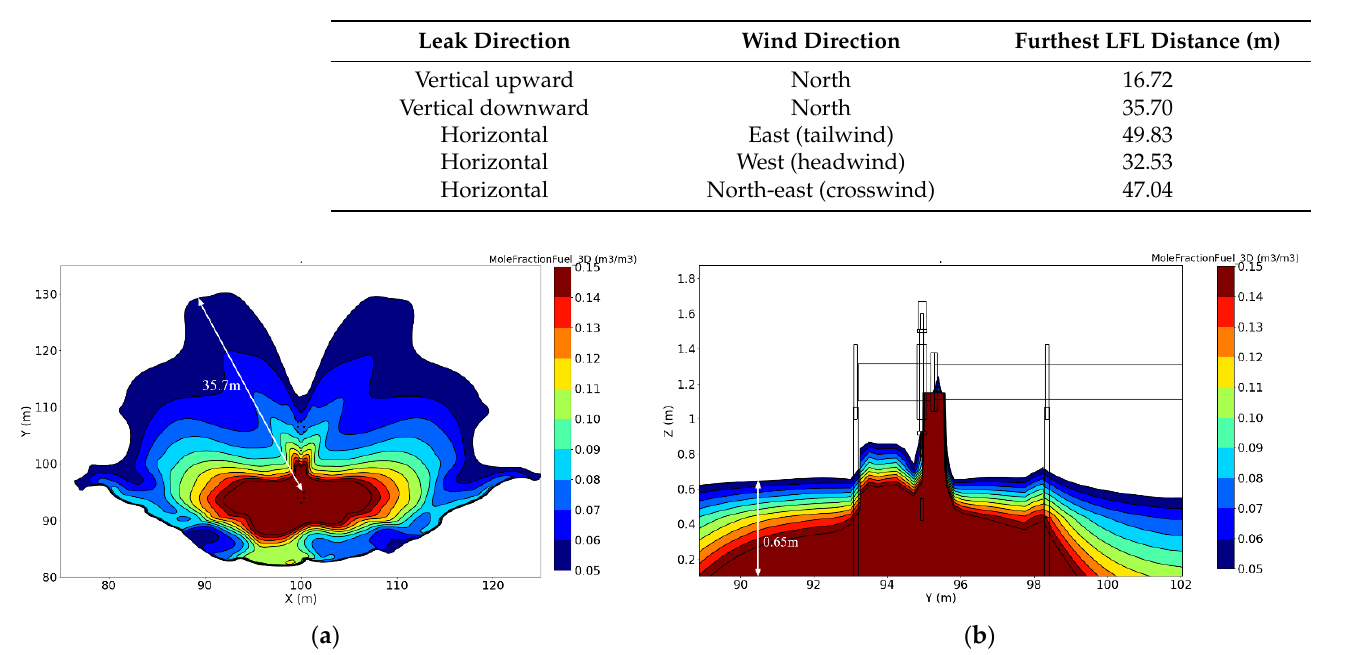
Table 2. LFL distance of leaks.